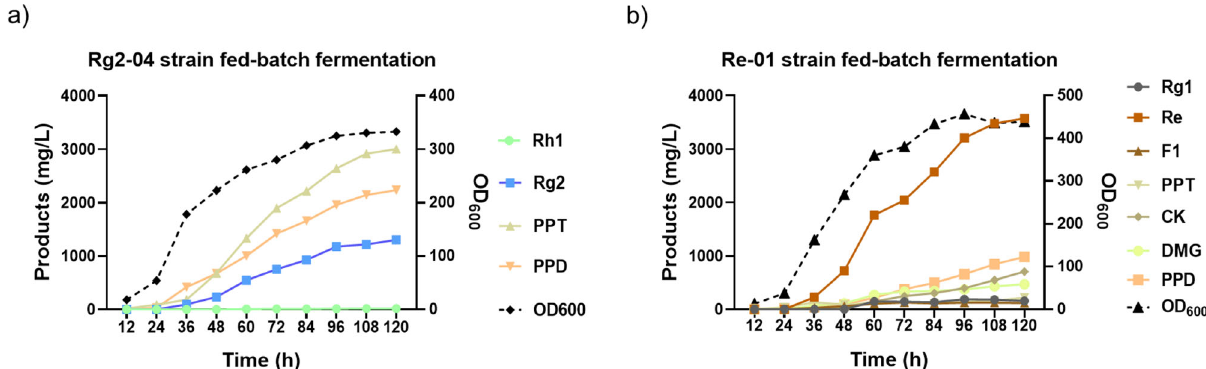
Fig. 6 Time course analysis of yeast strain growth and ginsenosides Rg2 and Re production in fed-batch fermentation. a Time course analysis of cell growth and triterpenoid production of strain Rg2-04. b Time course analysis of cell growth and triterpenoid production of strain Re-01.